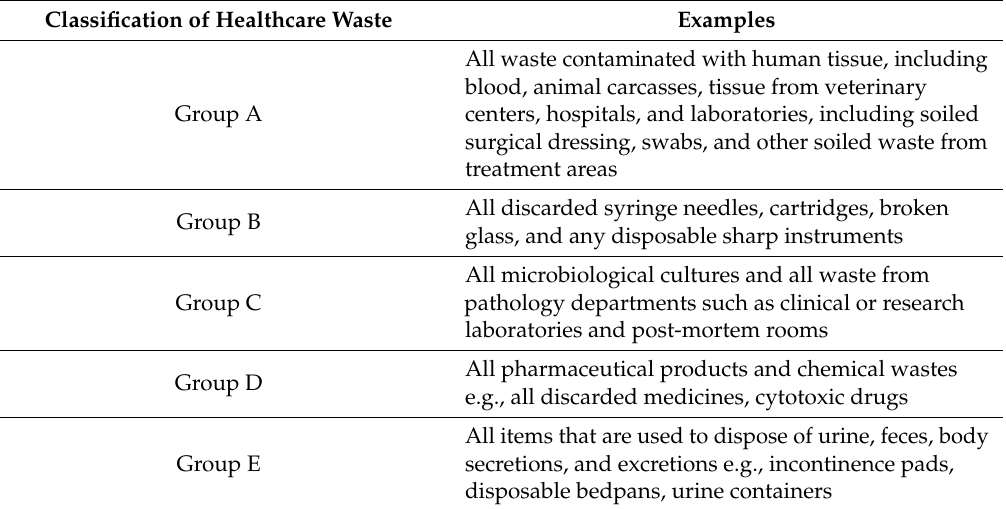
Table 4. Classification of healthcare waste by high-income